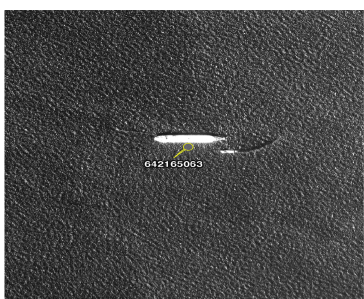
Figure 13. The ship SLOUG-FPSO extracted from the EROS-B image taken the 22 October 2016 at